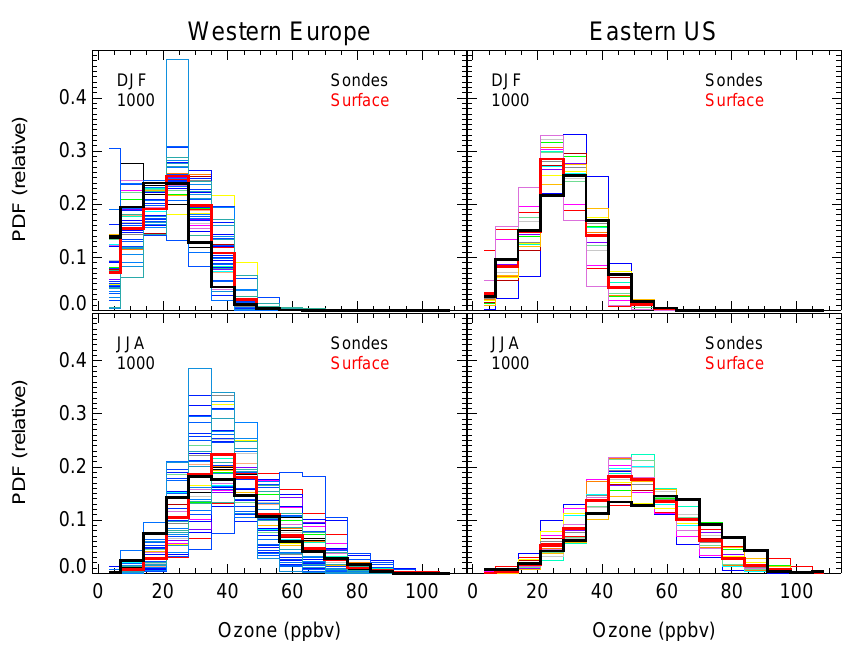
Fig. 7. Probability distribution functions (PDFs) of surface ozone from surface ozone stations with altitude location below 500 m (thin colored lines) for Western Europe (first column) and Eastern US (second column) and for DJF (top) and JJA (bottom). Further, regional aggregates of the PDFs from these surface observations are shown in each panel (red thick lines), as well as regional aggregates derived from ozonesonde observations at 1000 ± 50hPa (black thick lines). The location of selected stations is shown in Fig. 8.